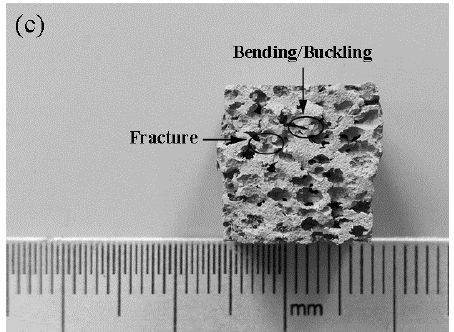
Figure 10. The macroscopic compressive deformation of the composite foams at a strain of ( a ) 0, ( b ) ~0.2, ( c ) ~0.3.